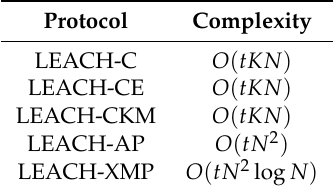
Table 2. Computational